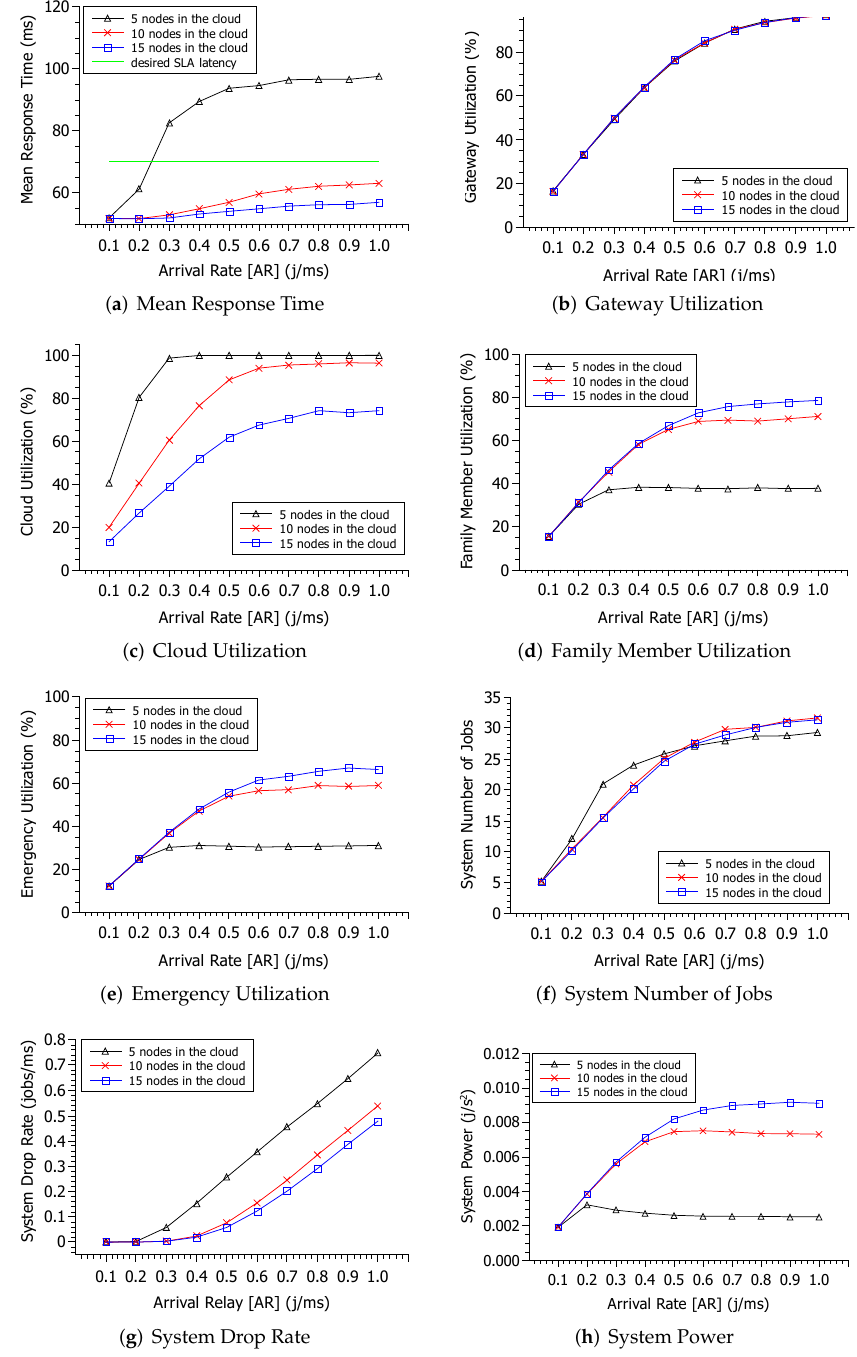
Figure 4. Analysis results varying the arrival rate of new